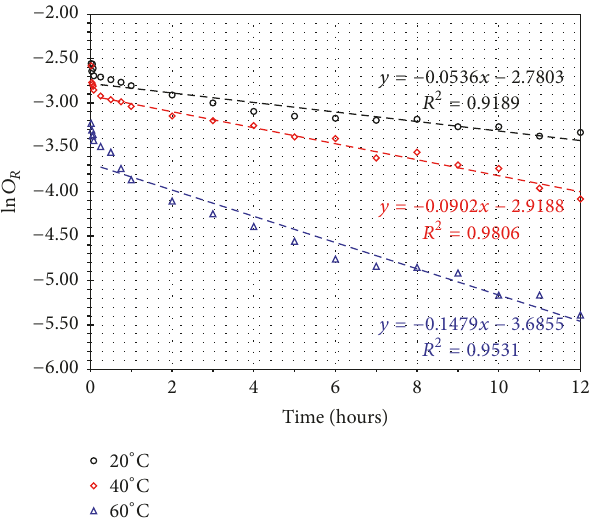
Figure 5: Distribution of the average particle size of the rice bran: nondefatted and defatted.